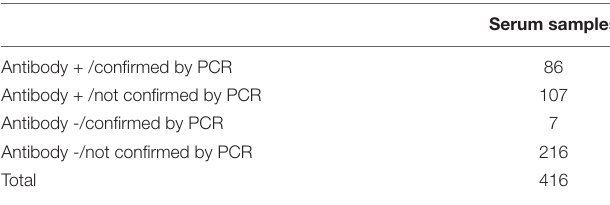
TABLE 1 | Serum classification by commercial serological assay and PCR confirmation.